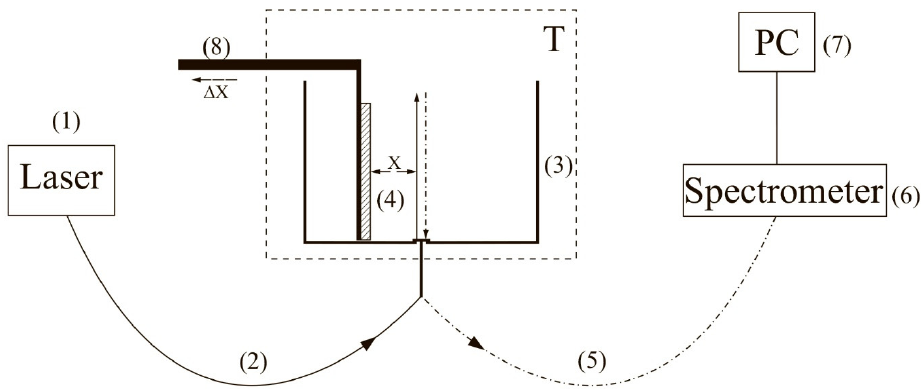
Figure 1. Schematic of the experimental setup. (1) laser, (2), (5) multi-mode optical fiber, (3) cell with a liquid sample, (4) Nafion plate, (6) spectrometer, (7) computer, (8) stage equipped with a micrometric horizontal feed for Nafion plate alignment relative to the optical axis, (T) thermostat.